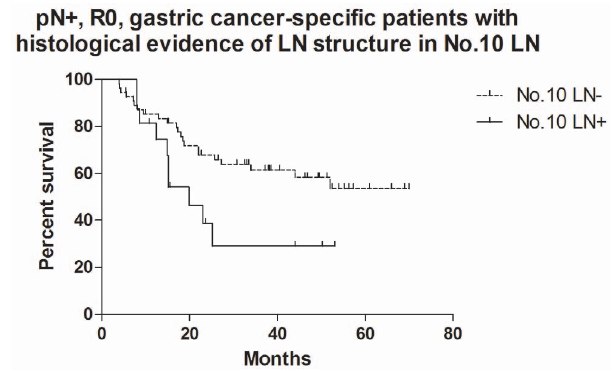
Figure 10. Kaplan-Meier survival analysis of pN2-3 stage gastric cancer specific + R0 resection group in all patients.